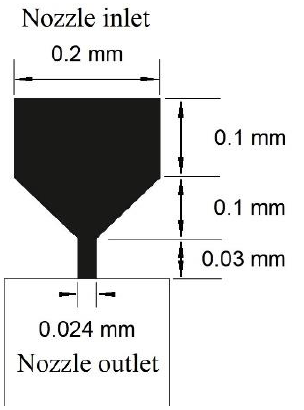
Figure 2. Geometric parameters of the inkjet nozzle. Initially, the space between the inlet and the nozzle outlet is filled with ink. Then, ink is ejected through the nozzle during a period of 2.0 µ s and it is consequently forced to flow out of the nozzle. When the ejection stops, a droplet volume still grows for a while and snaps off the nozzle. After that, the droplet is changing form and continues to travel until it hits the target. During this process, gravity g is considered, having a value 9.8066 m/s 2 . To control the droplet size and velocity during the ejection, a rectangular function is applied (Figure 3) for the inlet velocity that forces a pressure increase inside the modeled nozzle. It helps to set the length of the pulse and the value of the maximum nozzle inlet fluid velocity magnitude (maximum value 0.2 m/s which is a realistic value to increase pressure in the inkjet nozzle for inkjet printing). Both parameters can affect the resulting velocity of the ejected droplet, but the magnitude (depends on the time of the droplet formation) has a larger influence on the droplet